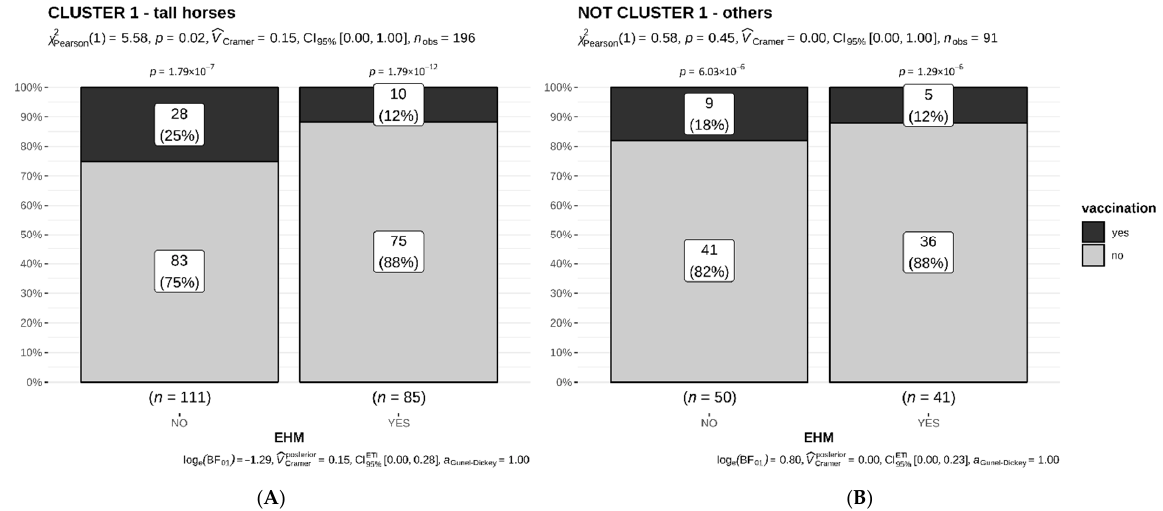
Figure 3. ( A ) Cluster 1 horses (genetically similar ‘tall’ horses) and 3 ( B ): all others ( not -cluster-1) stratified into animals with EHM (right bar, panel ( A ) or ( B )), or without EHM (left bar, panel ( A ) or ( B )), and further stratified vertically into EHV-unvaccinated (light gray) or EHV-vaccinated (dark gray) animals. The p-values above individual bars compare the proportions of vaccinated versus unvaccinated animals, indicating fewer animals were vaccinated. The chi-square test (results at top of figure) finds a benefit of vaccination in the prevention of EHM ( p = 0.02) for cluster 1 horses (panel ( A )). Those without EHM (left bar) were more frequently (25%) fully vaccinated when compared to horses with EHM, where only 12% were fully vaccinated. The difference in percentages is small (V Cramer = 0.15 [21]). The Bayes Factor (BF) supports this result by indicating a substantial evidence for the bene fi t of vaccination in EHM prevention (log(BF01) = − 1.29 [22]). The Bayesian effect size is, however, also small (V Cramer = 0.16; 95%; Highest Density Intervals 0.03; 0.28). Findings for not -clus- ter-1 animal results were not significant, likely due to small sample size. The chi-square test (results: top of figure, panel ( B )) finds no relationship between vaccination and EHM ( p = 0.45, no evidence against the null hypothesis). The difference in percentages is small (V Cramer = 0.0 [21]). The Bayes Factor (BF) supports the latter result by indicating no evidence for the null or for the alternative hypothesis (log(BF01) = 0.80 [22]) and by showing a very small Bayesian effect size (V Cramer = 0.09; 95% Highest Density Intervals 0; 0.23). 3. Results 3.1. Operation Characteristics Premises differed in many aspects, including the type of husbandry (individual boxes, paddock boxes, or group husbandry); number and size of units (Table 2); and if they were a mixed-breed vs. single- or predominate-breed operation. All farms allowed boarding to some degree, defined as renting boxes to individual horse owners or accept- ing horses from elsewhere for a limited time. Some farms had additional functions (breed- ing (B and C); old horse retirement (E); and riding instruction (E, J, and L). It is noteworthy that the consequence of ‘additional function’ is that a variable proportion of animals on a farm are owned by a single person, often the farm owner/management. The predominant breed on farms A and B was the American Quarter Horse, and Warmblood on farms C, D, F, H, and J–M. In addition to Warmbloods, farms J, K, and M housed many sport ponies without specified breed backgrounds. Farms E, G, and I were mixed-breed operations. Most farms (A–D, F, H, J, L, and M) had open sidings between boxes (exception: farm K). Farms A, C, and D had mostly single box aisles; other animals were kept in small group husbandry systems. Farm E had an indoor group husbandry system with groups of 4 to 24 horses. While group-housed during nights, all animals were combined in a large out- door paddock during the daytime (detailed information: [12]).